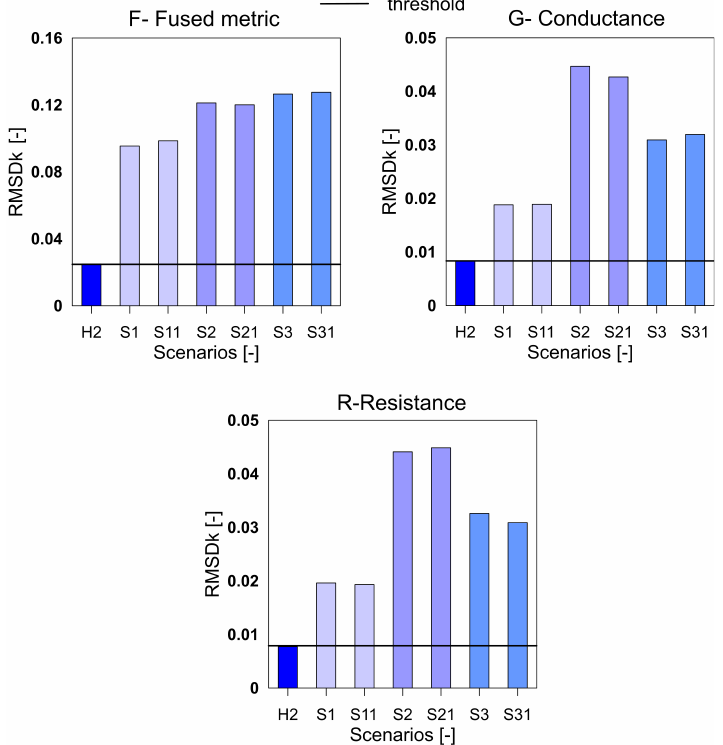
Figure 10. The RMSDk index for the variables F, G and R for GFRP